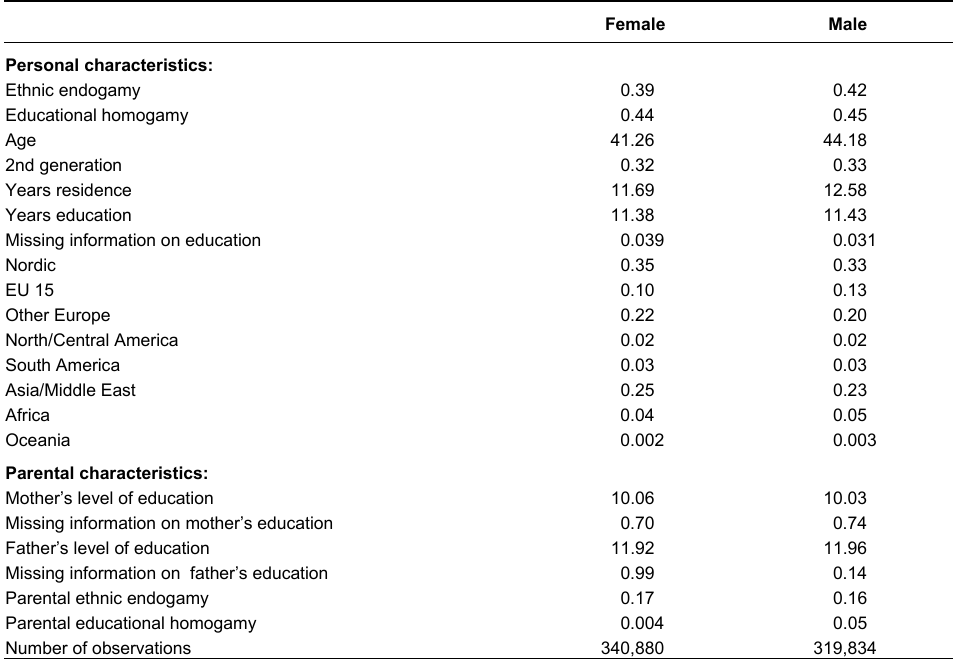
Table 2: Descriptive statistics, by gender